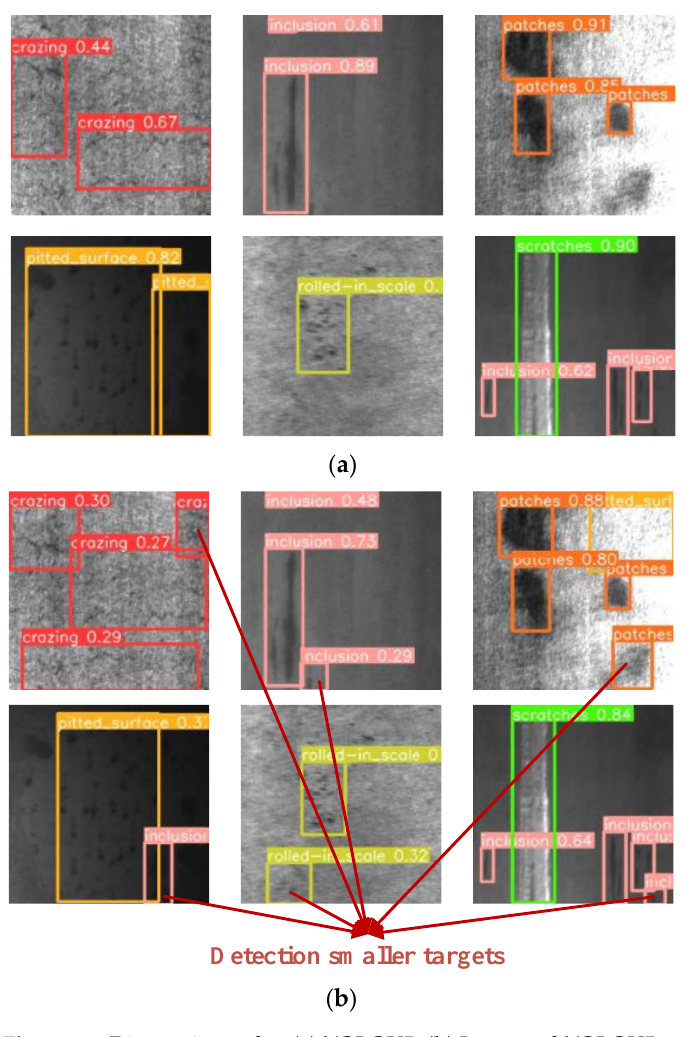
Figure 14. Diagnosis results: ( a ) YOLOV5; ( b ) Improved YOLOV5.